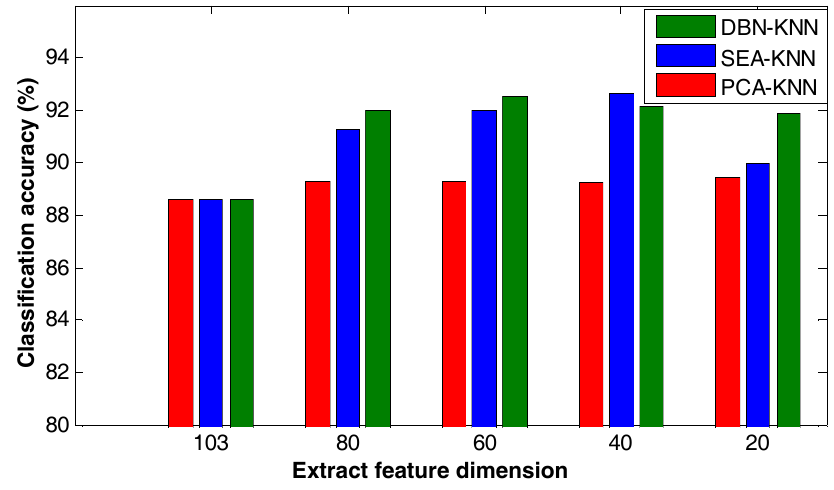
Figure 16. Comparison of depth learning and principal component analysis.